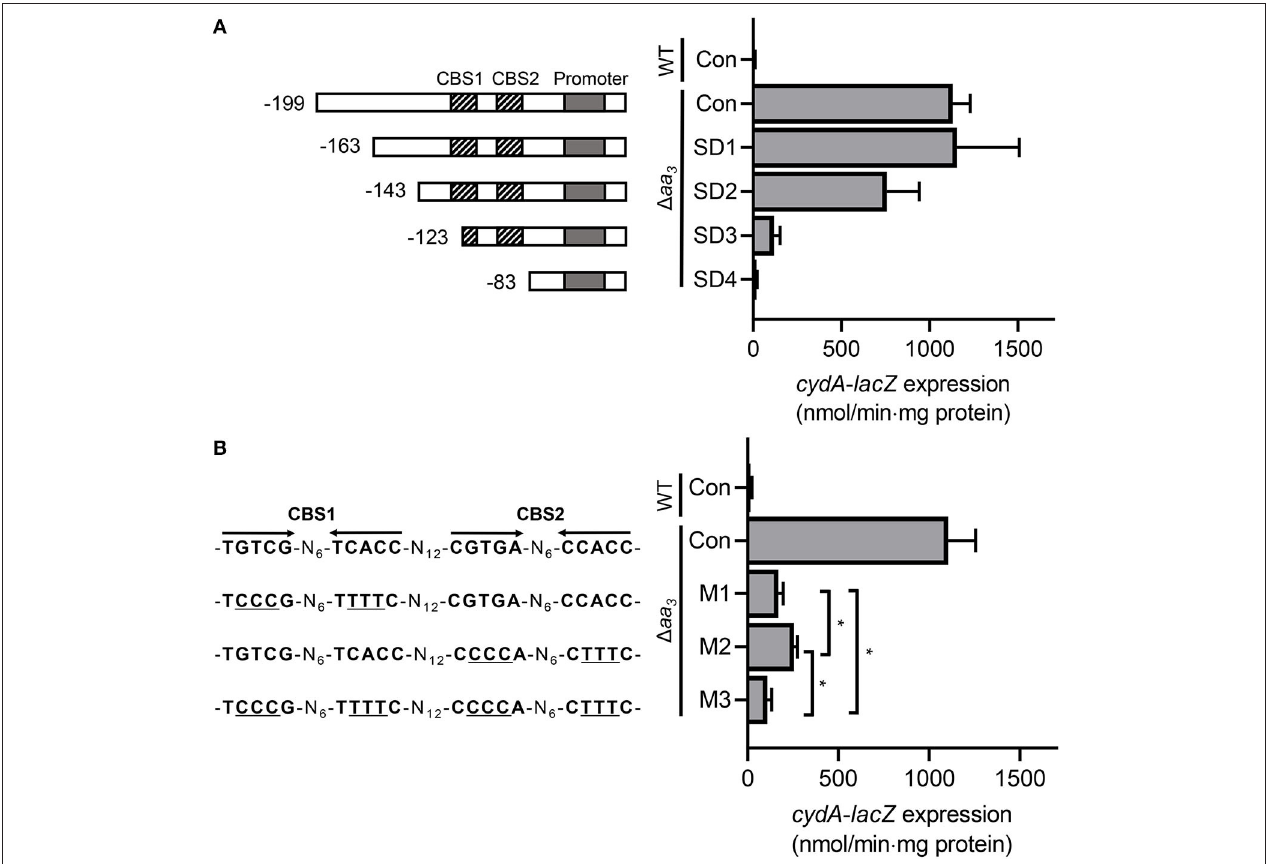
FIGURE 6 | Effects of deletions and mutations in the Crp-binding sites (CBS1 and CBS2) on expression of the cydAB operon. (A) The cydA promoter activity was determined using the pNCIIcydA-derived cydA::lacZ translational fusions containing serial deletions of the cydA upstream region (pNCIISD1, pNCIISD2, pNCIISD3, and pNCIISD4). (B) The cydA promoter activity was determined using several pNCIIcydA derivatives containing mutations in the Crp-binding sites (pNCIIM1, pNCIIM2, and pNCIIM3). The mutations in the Crp-binding sites of the cydA :: lacZ translational fusions are presented on the left. The mutations within CBS1 and CBS2 are indicated by underlines. The WT and 1 aa 3 mutant strains of M. smegmatis harboring the cydA::lacZ translational fusion plasmids were grown aerobically to an OD 600 of 0.45–0.5 in 7H9-glucose medium. Cell crude extracts were used to determined β -galactosidase activity. All values provided are the averages of the results from three biological replicates. The error bars indicate the standard deviations. Statistical significance was determined by two-tailed Student’s t -test. * p < 0.05. Con, pNCIIcydA; SD1-SD4, pNCIISD1- pNCIISD4; M1-M3,